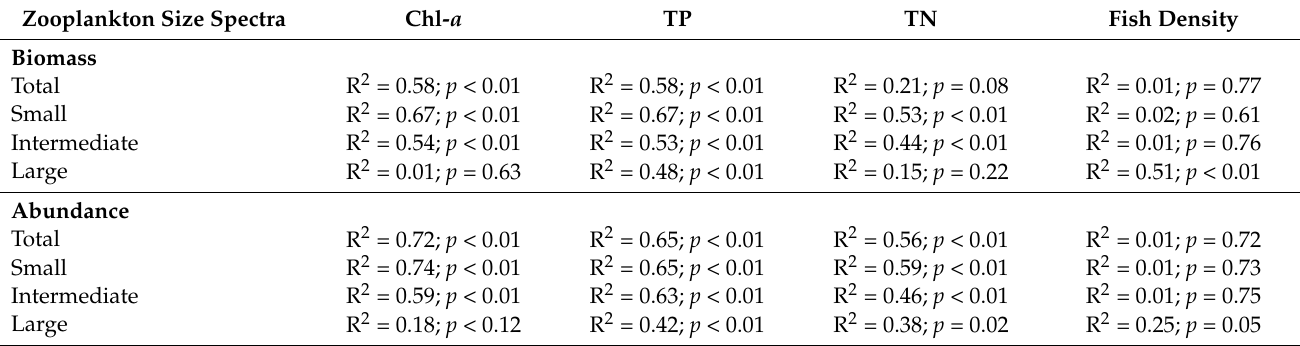
Figure 6. Association of the zooplankton total abundance with ( a ) chlorophyll- a , ( b ) total phosphorus, ( c ) total nitrogen, and ( d ) fish density. All data were log (x + 1) transformed prior to analysis. Table 6. Results of linear regression analysis model showing the correlation between zooplankton biomass and abundance and trophic indicators: chlorophyll- a (chl- a ), total phosphorus (TP), total nitrogen (TN), and fish density. Values indicate the correlation coefficient (R 2 ) and p -value; when p values are greater than 0.05, there is no significant relationship between the two